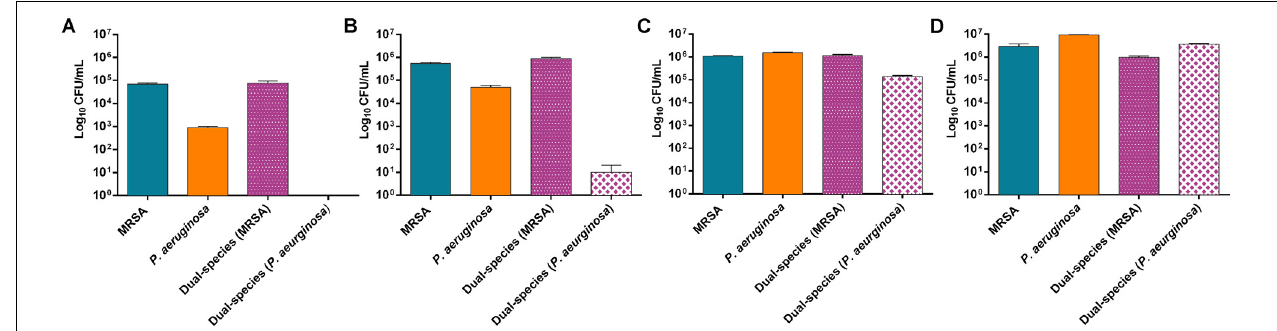
FIGURE 1 | Distribution pattern of bacterial populations over the time. Number of viable cells (in log10 CFU/mL) of P. aeruginosa and MRSA on mono- and dual-species biofilms formed after 3 h (A) , 6 h (B) , 12 h (C) and 24 h (D) . Data are reported as CFU/mL mean ± standard deviation of at least three independent experiments. Figure 2 | Dual-species biofilm formed by MRSA (ATCC 43300) and P. aeruginosa (ATCC 27853) on porous glass beads after 24 h of incubation. Image (B) is a close-up from (A) . Numbers 1 and 2 indicate a MRSA bacterium and a P. aeruginosa bacterium, respectively, whereas three and four point out a water channel and the extracellular polymeric matrix of the biofilm correspondingly.